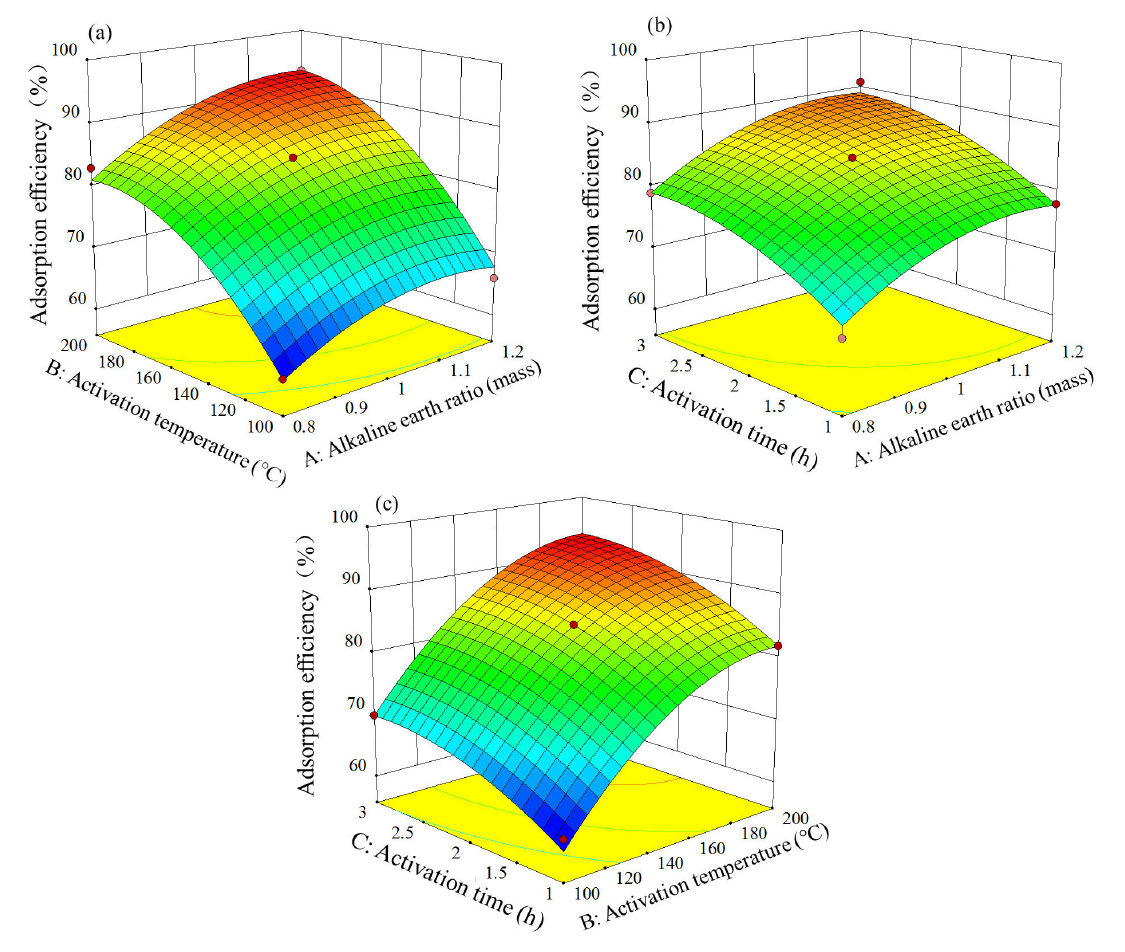
Figure 6. Response surface plots for adsorption efficiency as a function of activation temperature and NaOH/illite ratio ( a ); activation time and NaOH/illite ratio ( b ); activation time and activation temperature ( c ).